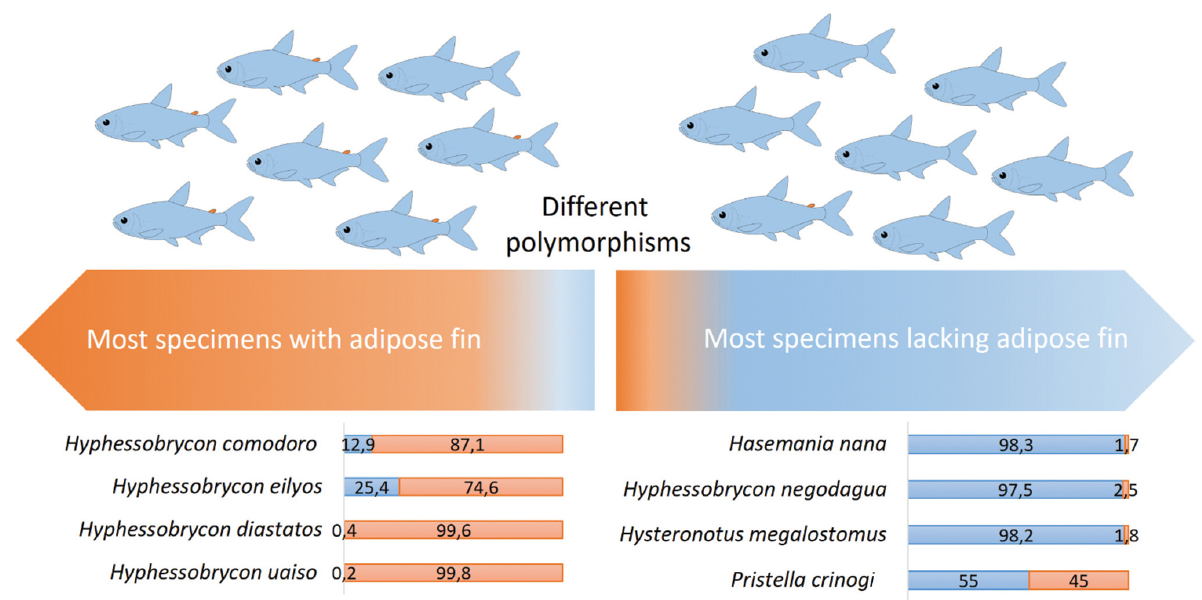
FIGURE 5 | Graph showing the adipose fin variation in characids. Note that not all polymorphisms are the same condition: some species have more specimens with developed adipose whereas other species have more specimens lacking that fin. Numbers in graphic are percentages of specimens bearing adipose fin (orange) or lacking adipose fin (blue). Further details in Tab.